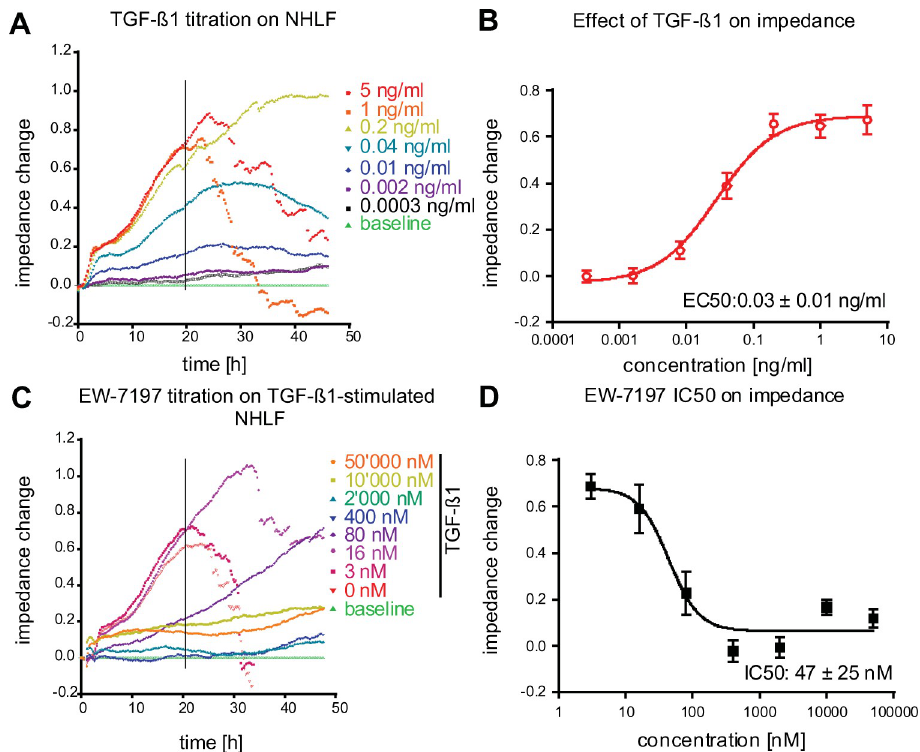
Fig 2. Impedance analysis of TGF– β 1–stimulated fibroblast to myofibroblast differentiation and inhibition thereof with the ALK5 inhibitor EW–7197. (A) NHLF fibroblasts were stimulated at t = 0 h with different concentrations of TGF– β 1 (0–5 ng / ml) and impedance responses were followed for 48 h. (C) NHLF cells were incubated with a dilution series of the ALK5–blocker EW–7197 (0–50,000 nM) and then stimulated with 5 ng / ml TGF– β 1. Impedance responses were monitored for 48 h. Concentration response curves of TGF– β 1 (B), and of EW– 7197 in presence of 5 ng / ml TGF– β 1 (D), where then generated with baseline (0 ng / ml TGF– β 1) subtracted impedance values at t = 20 h post TGF– β 1 addition (mean ± SD, n = 8). Representative experiments are shown in A and C.